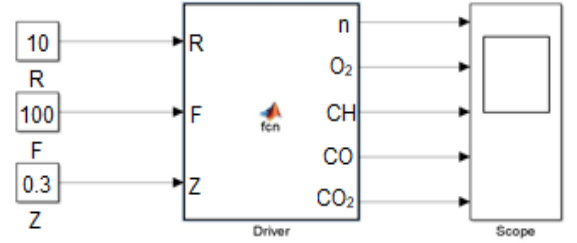
Figure 6. The dependence of the concentration of CH in exhaust gases on the equivalent resistance of the catalytic